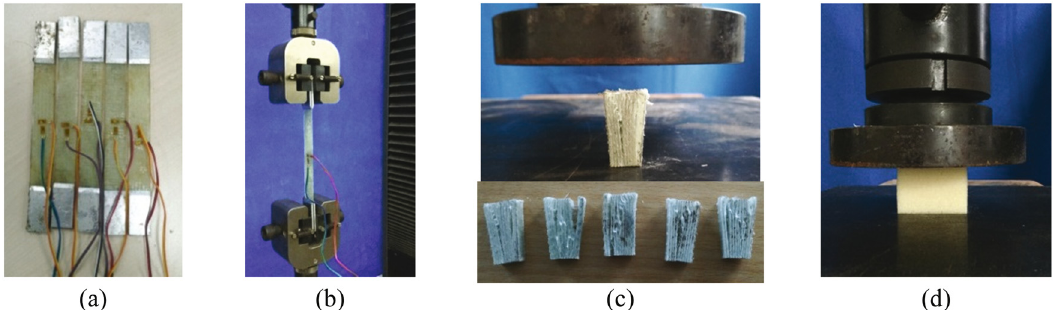
Figure 3: Material properties test: ( a ) GFRP sheets: fi ve tension coupons; ( b ) tension test of GFRP sheets; ( c ) compression test of GFRP sheets; and ( d ) compression test of PU